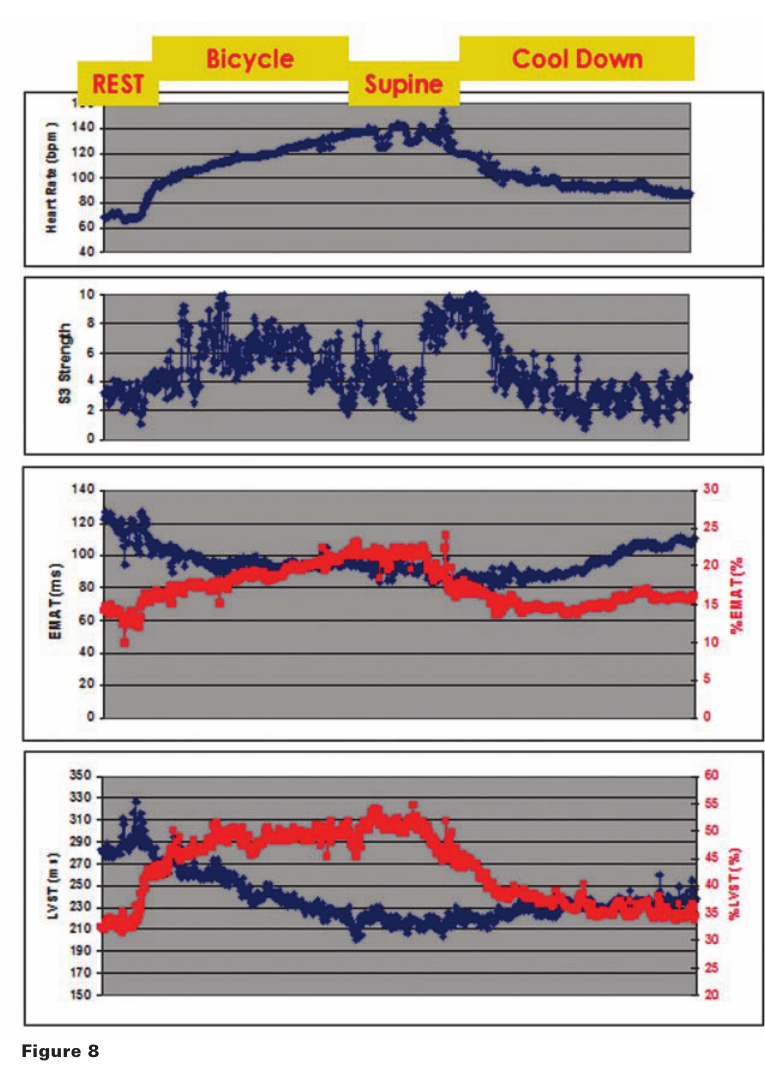
Continuous recording of acoustic cardiography parameter throughout a cardiac bicycle stress test. The recording of acoustic cardiography parameters during physical stress testing reveals the ability of the cardiovascular system to adapt to the increased metabolic demand. With an increase in the heart rate the cardiac cycle becomes shorter; hence systole needs to shorten in order to allow sufficient time for diastole and therefore, diastolic coronary perfusion. Abbreviations: EMAT – electromechanical activation time, %EMAT – the proportion of the RR interval that the EMAT occupies; LVST – left ventricular systolic time; %LVST – the proportion of the RR interval that the LVST occupies; S3 – third heart